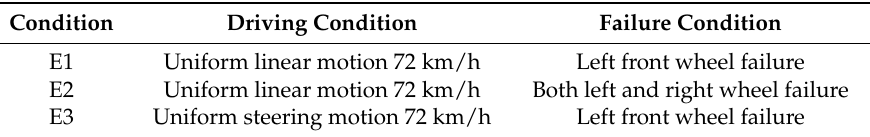
Figure 6. Driving simulator platform. Table 9. Special conditions of experimental verification.